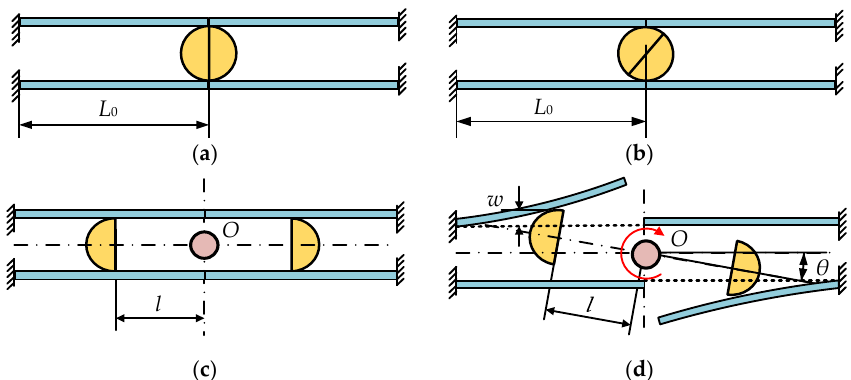
Figure 3. The overall configuration of the variable stiffness actuator. ( a ) The rollers are located at the rotating center (initial state). ( b ) The rollers are located at the rotating center (transmission state); ( c ) The distance from the roller to the center of rotation is l (initial state). ( d ) The distance from the roller to the center of rotation is l (transmission state).